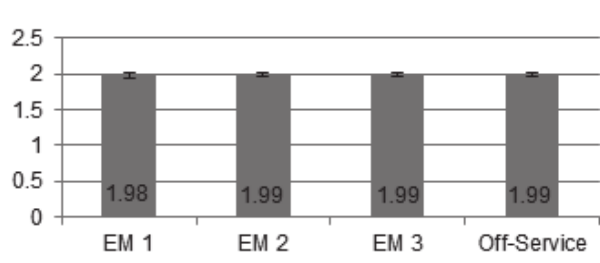
Figure 2. Attending patients per hour by resident training level,